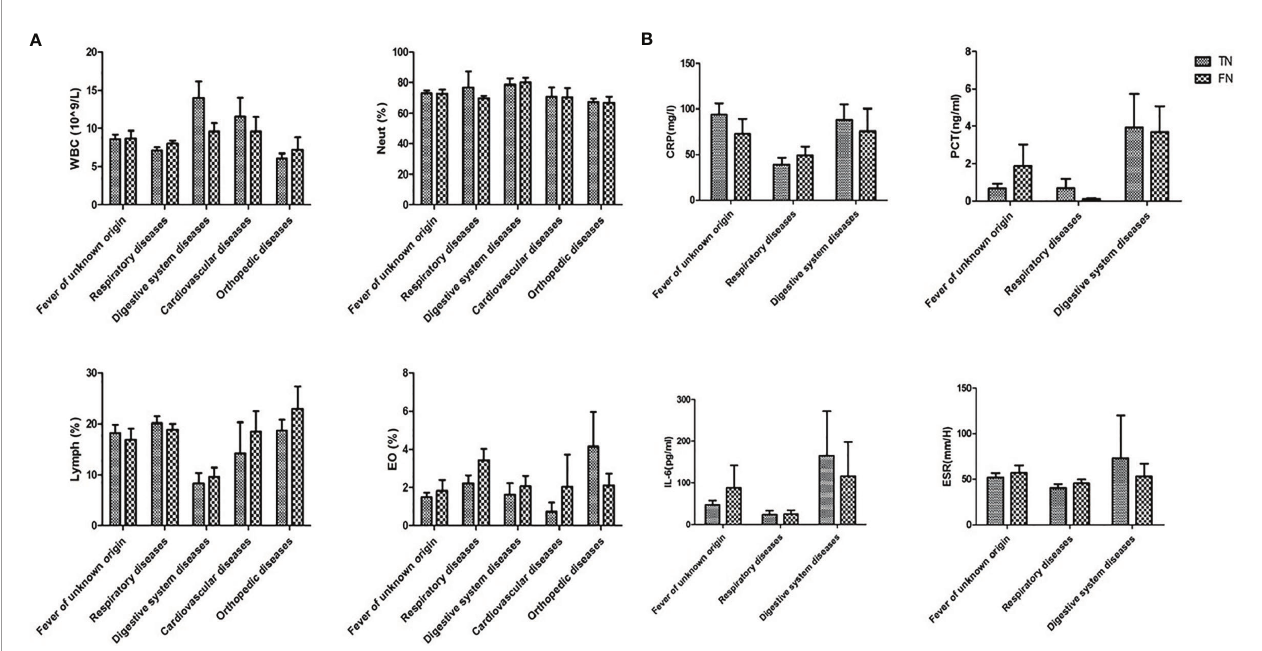
FIGURE 7 | Comparison of infection indexes between TN and FN samples. (A) WBC, Neut, Lymph, EC, (B) CRP, PCT, IL-6, ESR were compared between TN and FN samples in different diseases. WBC, leukocyte; Neut, neutrophil; Lymph, lymphocyte; EO, eosinophilia; CRP, C-reactive protein; PCT, procalcitonin; IL-6, interleukin-6; ESR, erythrocyte sedimentation rate; TN, true negative; FN, false